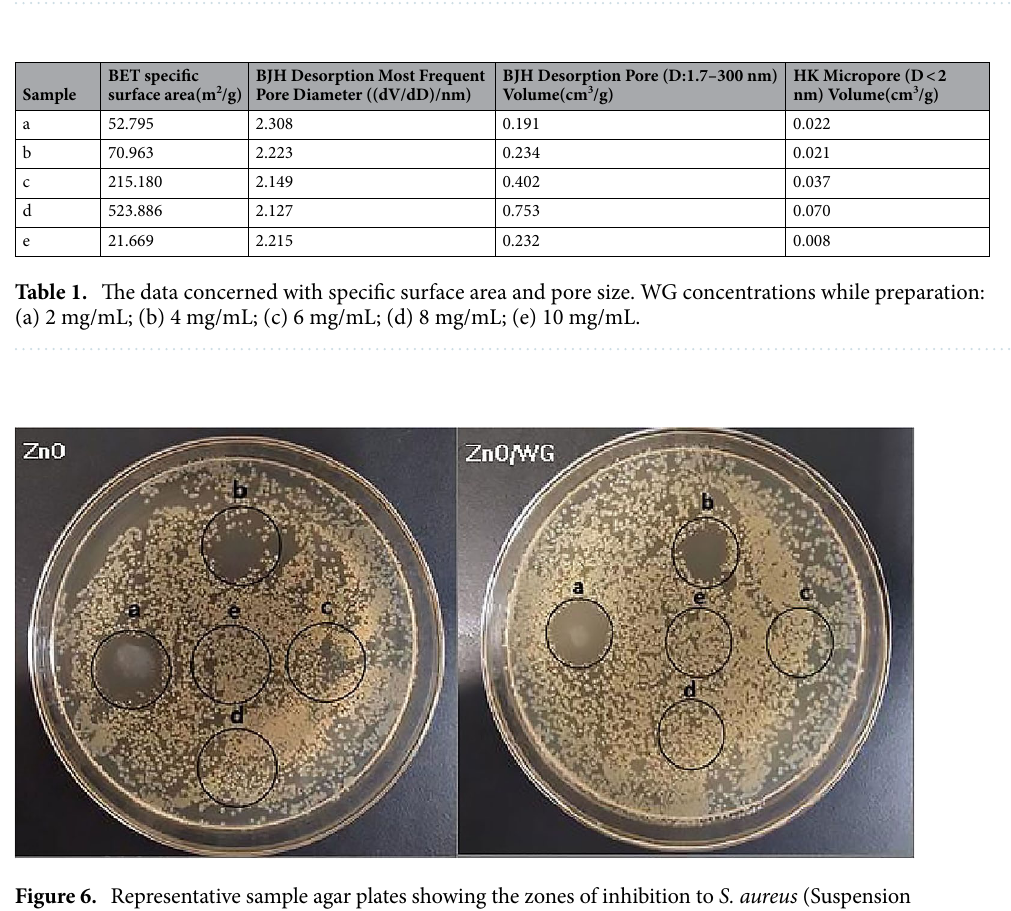
Figure 6. Representative sample agar plates showing the zones of inhibition to S. aureus (Suspension concentrations of samples: ( a ) 10 mg/mL; ( b ) 5 mg/mL; ( c ) 2 mg/mL; ( d ) 1 mg/mL; ( e )